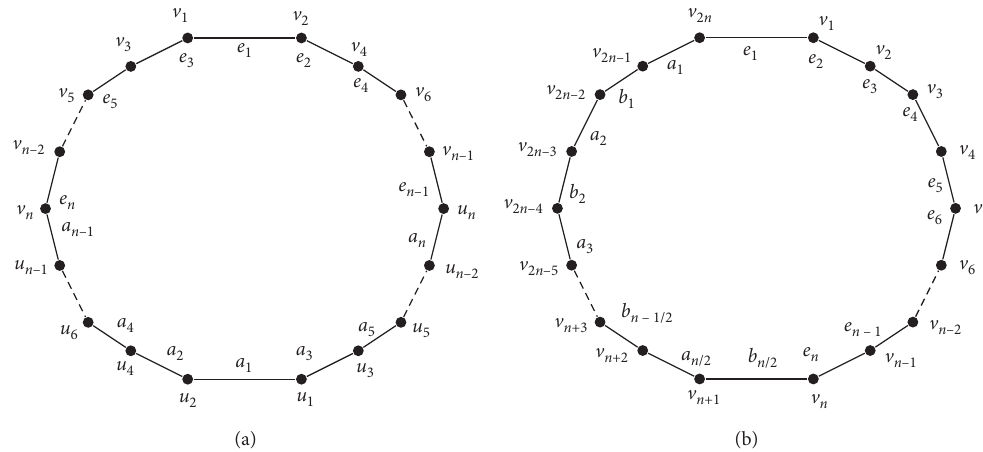
Figure 17: (a) C with ordinary labeling when n is odd. (b) C 2 n